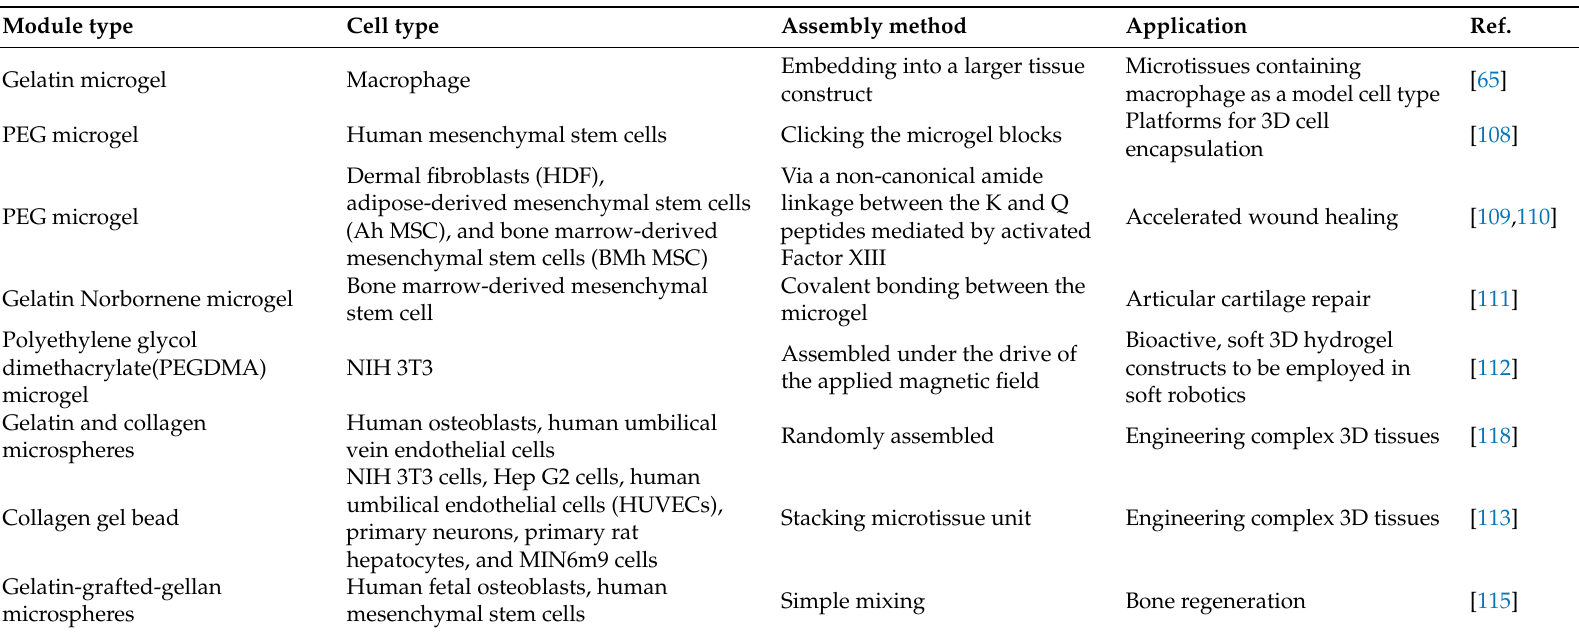
Table 4. Examples of cell-laden module for constructing 3D engineering